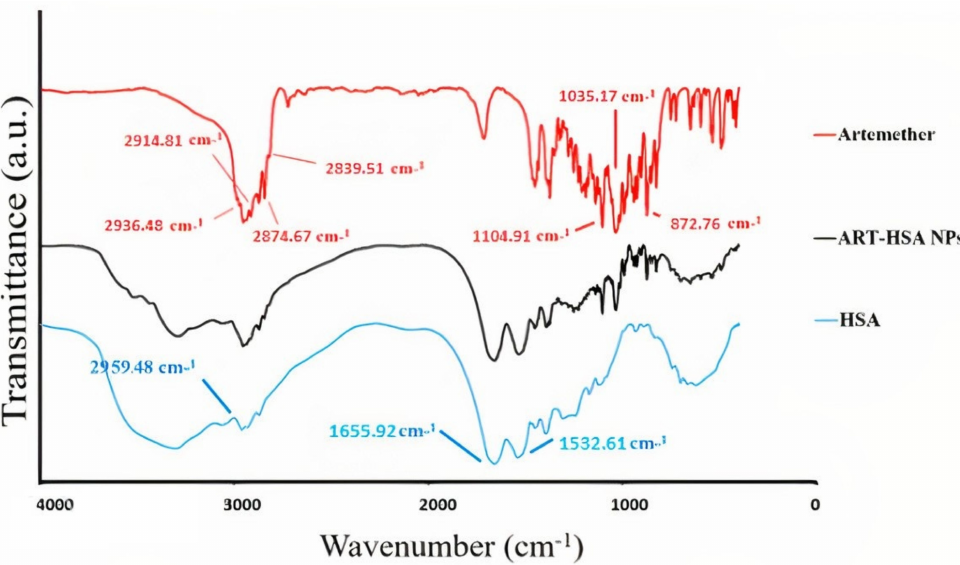
Figure 1. The FTIR results of artemether, albumin and ARM-Alb NPs. The presence of the main peaks of artemether and albumin in the nanoparticle structure indicates that their structure remains intact after the encapsulation process.